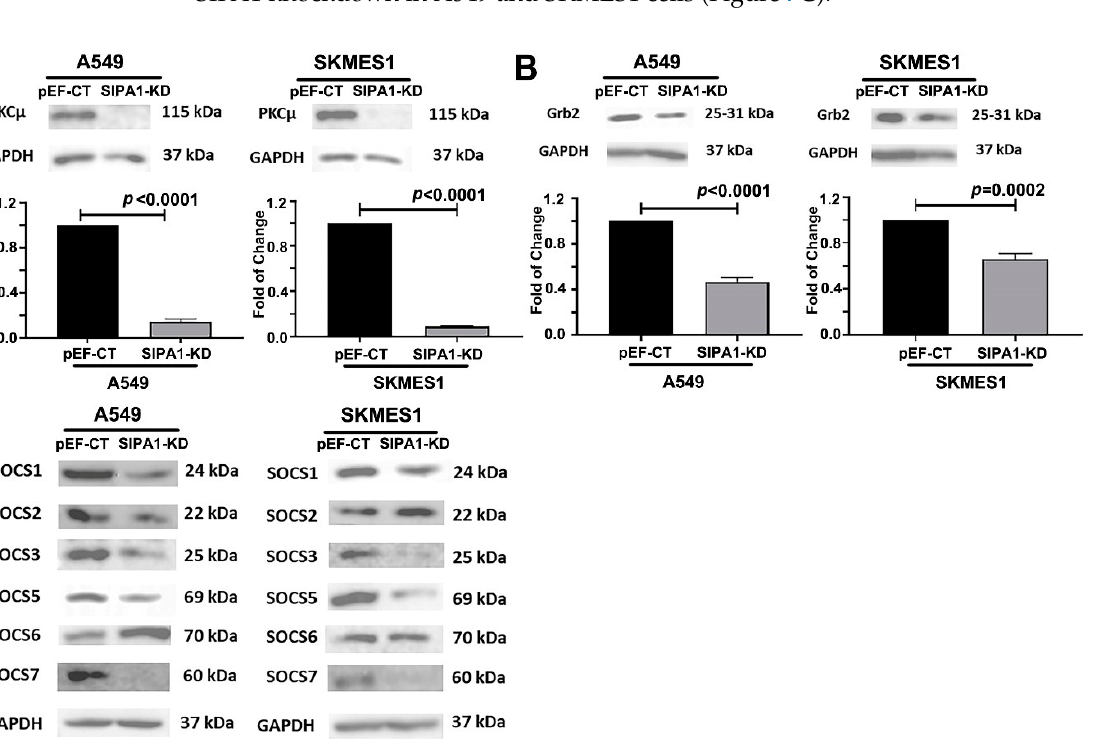
Figure 7. The key molecules regulated by the interaction of SIPA1 with HGF/MET signaling pathway in human lung cancer cells. The impact of knockdown of SIPA1 on the protein level of PKC µ ( A ), Grb2 ( B ), and SOCS family ( C ) in A549 and SKMES1 lung cancer cell lines examined using western blotting.